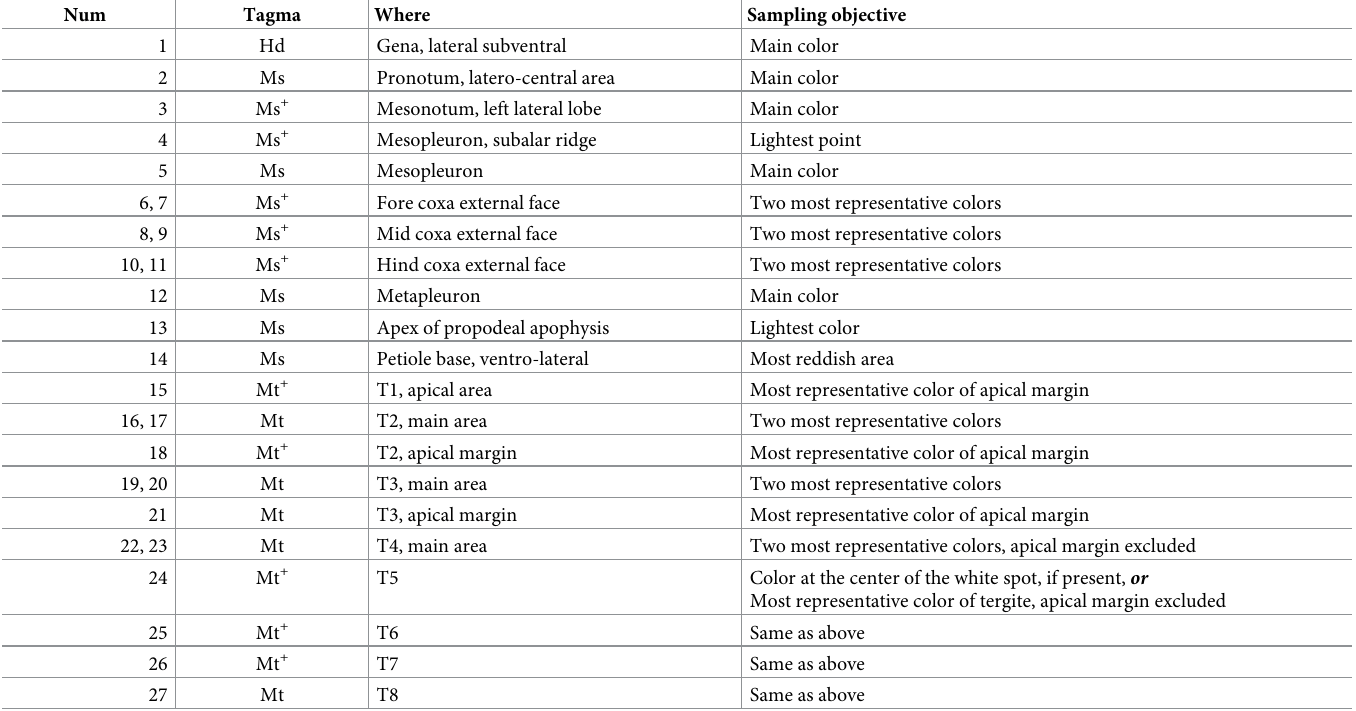
Table 2. External body areas sampled for RGB values on all available female specimens of Cryptoxenodon metamorphus sp. nov. Specimens were photographed in lateral (left) view for characters 0–12, and dorsal view for the remaining characters. Num Tagma